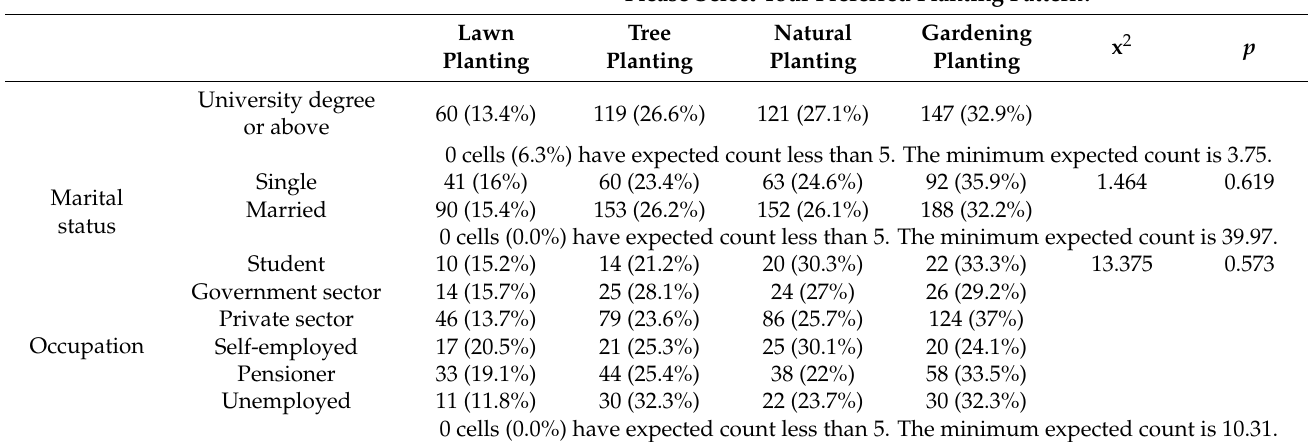
Table A2. Cont. Lawn Planting